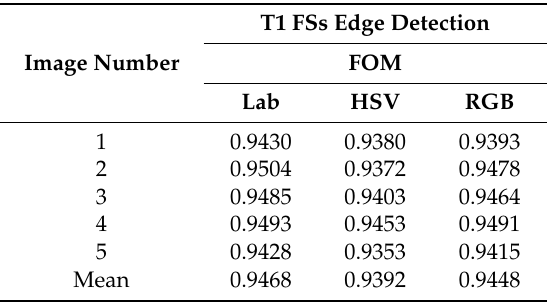
Table 3. T1 FSs edge detection applied on Lab, HSV, and RGB images.